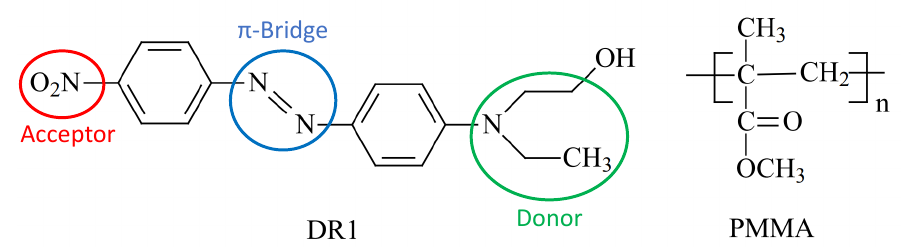
Figure 1. Chemical structure of the organic chromophore DR1 ( left ) and the polymer PMMA ( right ) employed as the EO